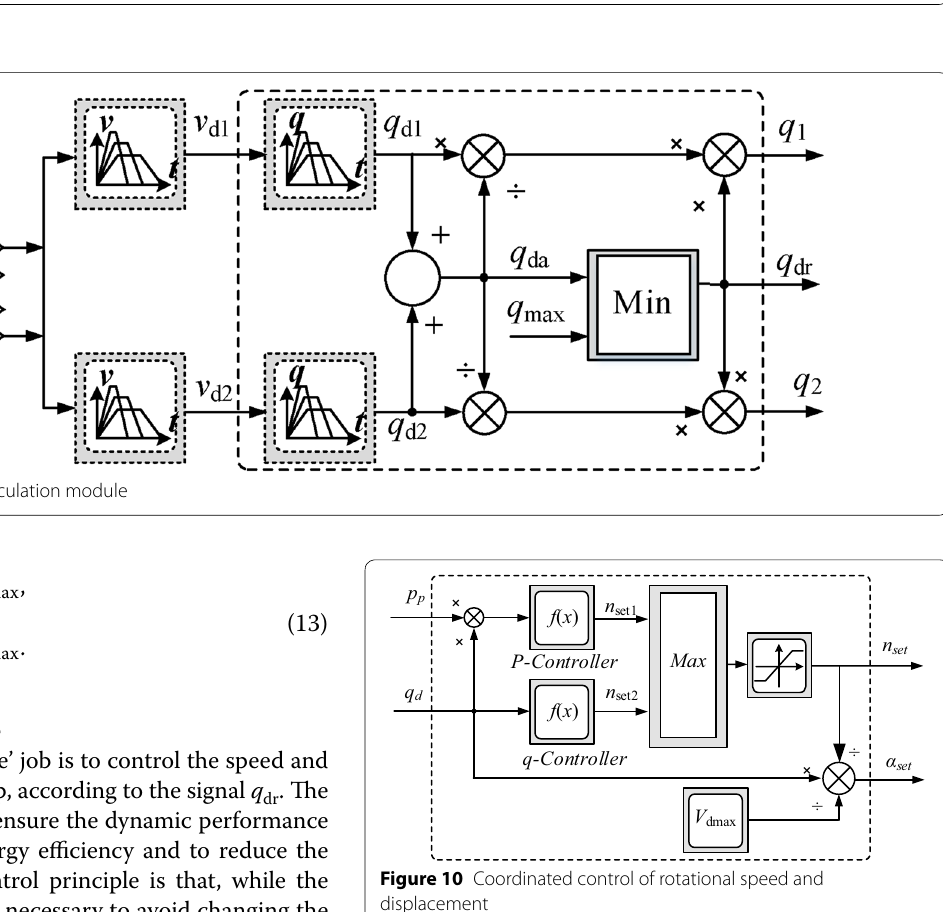
Figure 8 System architecture for excavator